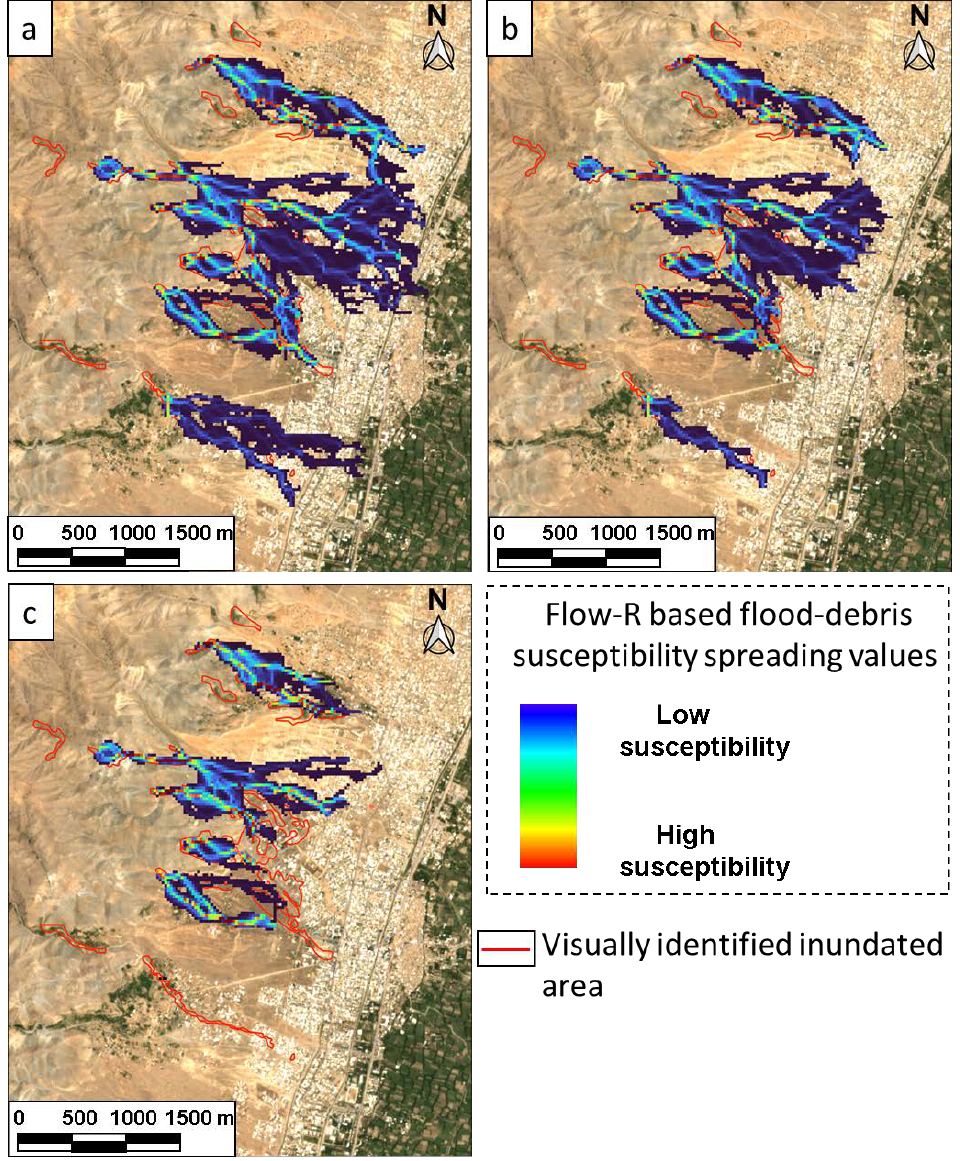
Figure 18. Flow-R generated flood-debris susceptibility map using a four-degree travel angle illustrated in ( a ), five-degree travel angle in ( b ), and six-degree travel angle in ( c ).